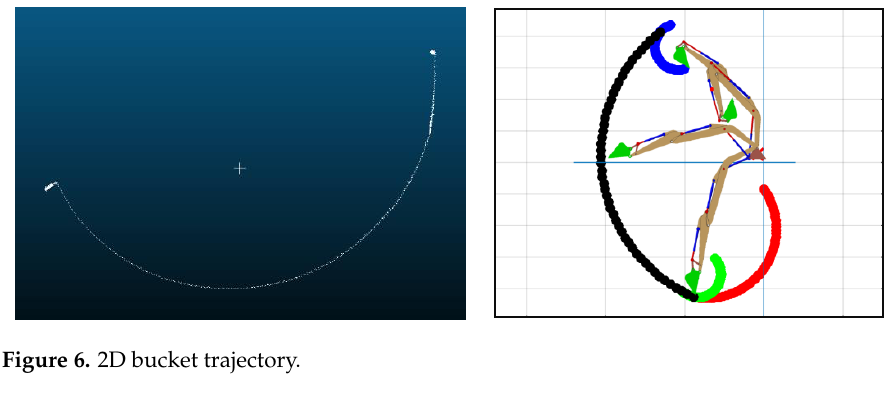
Figure 5. Bucket actuator and corresponding four-bar mechanism.